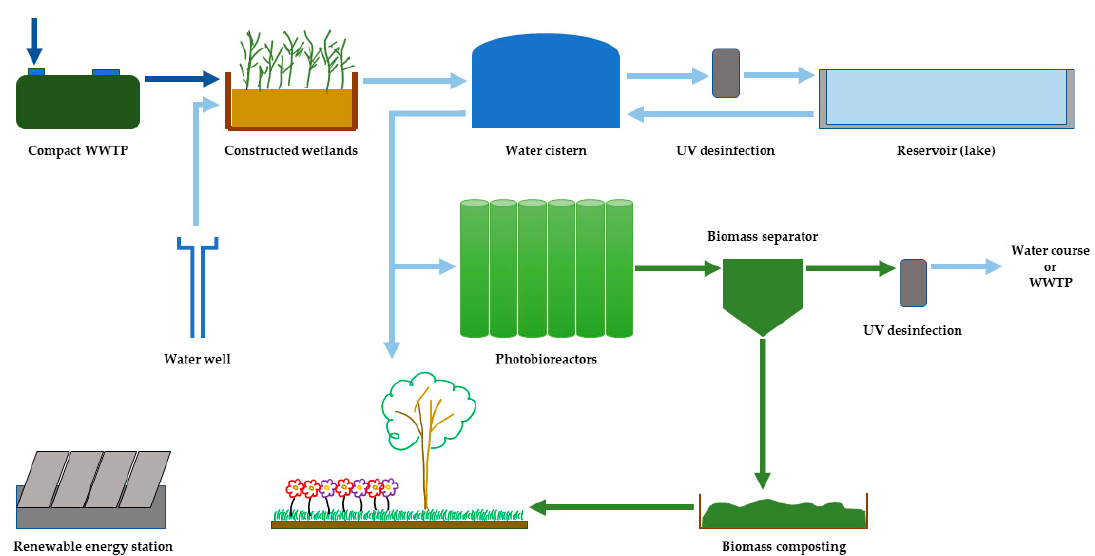
Figure 5. Scheme of the proposed solution to produce reclaimed water for irrigation with constructed wetlands and integration of microalgae production for water polishing and compost production.